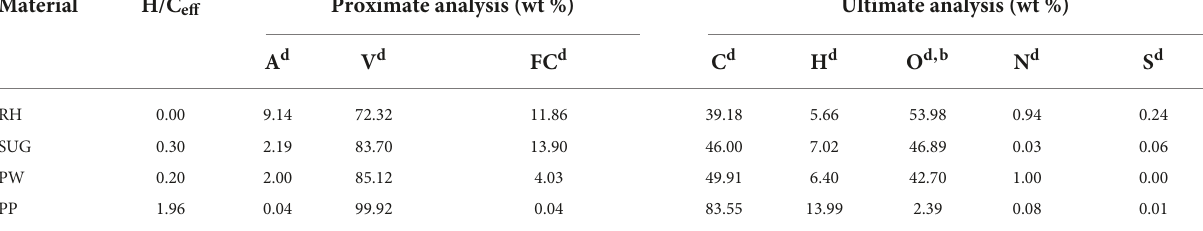
TABLE 1 Proximate and ultimate analysis of the raw